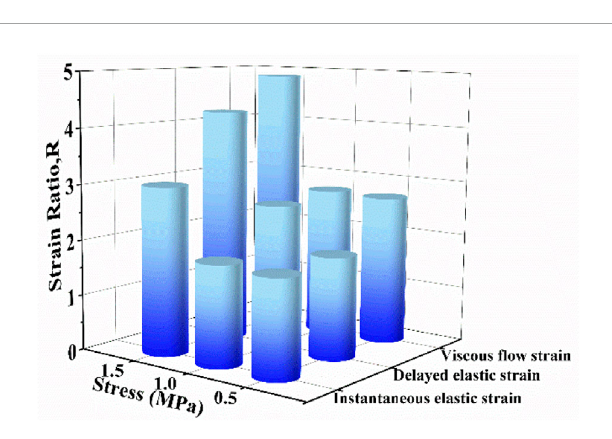
FIGURE 8 The strain ratio as a function of stress level for instantaneous elastic strain, delayed elastic strain and viscous fl ow